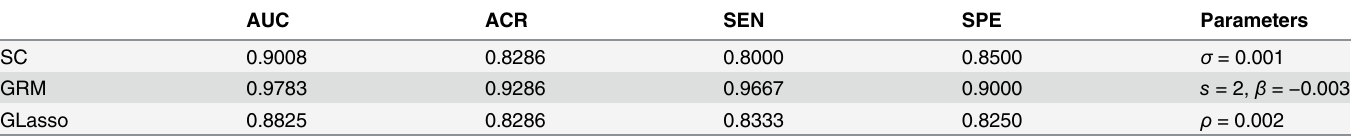
Table 3. Performance metrics and parameters of PiB-PET data